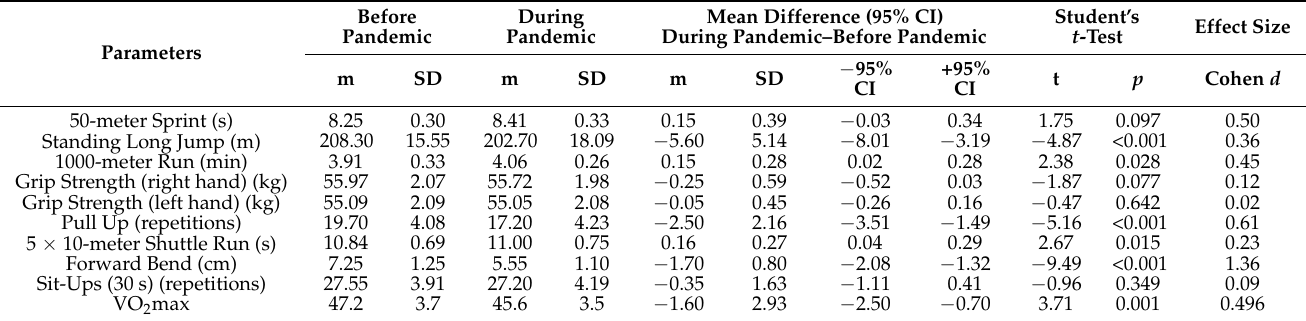
Table 3. The impact of the pandemic on changes in selected parameters in kickboxers. Before During Mean Difference (95% CI) Pandemic Pandemic During Pandemic–Before Pandemic Variable